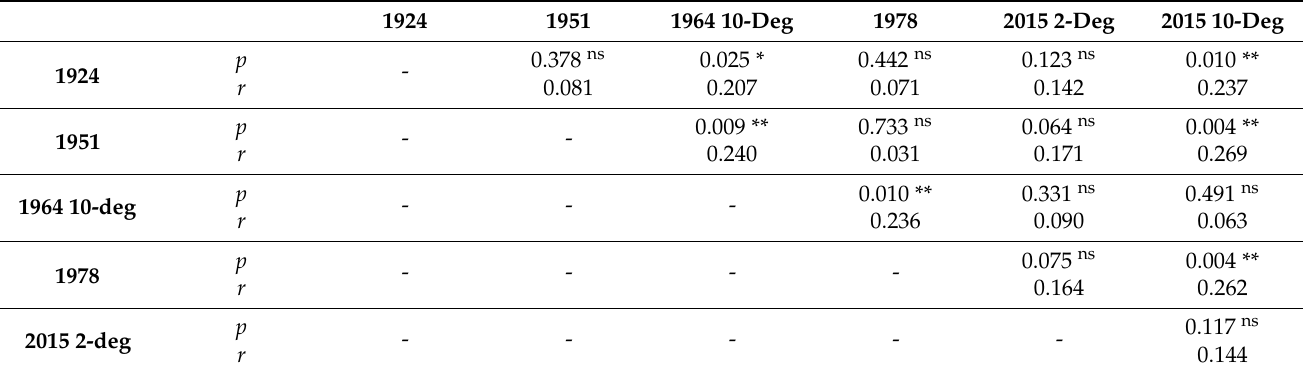
Table 5. Rank sum test and effect size for CIE 1976 u (cid:48) ( p -value and effect size ( r )).